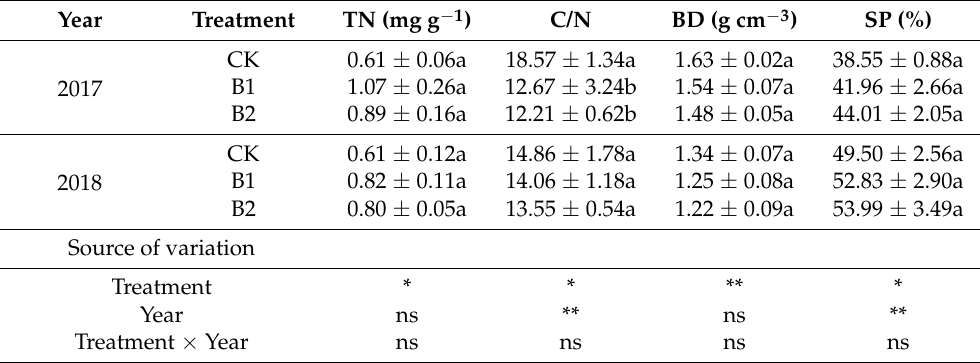
Table 2. Soil properties of topsoil (0–20 cm) in maize field following biochar and nitrogen fertilizer